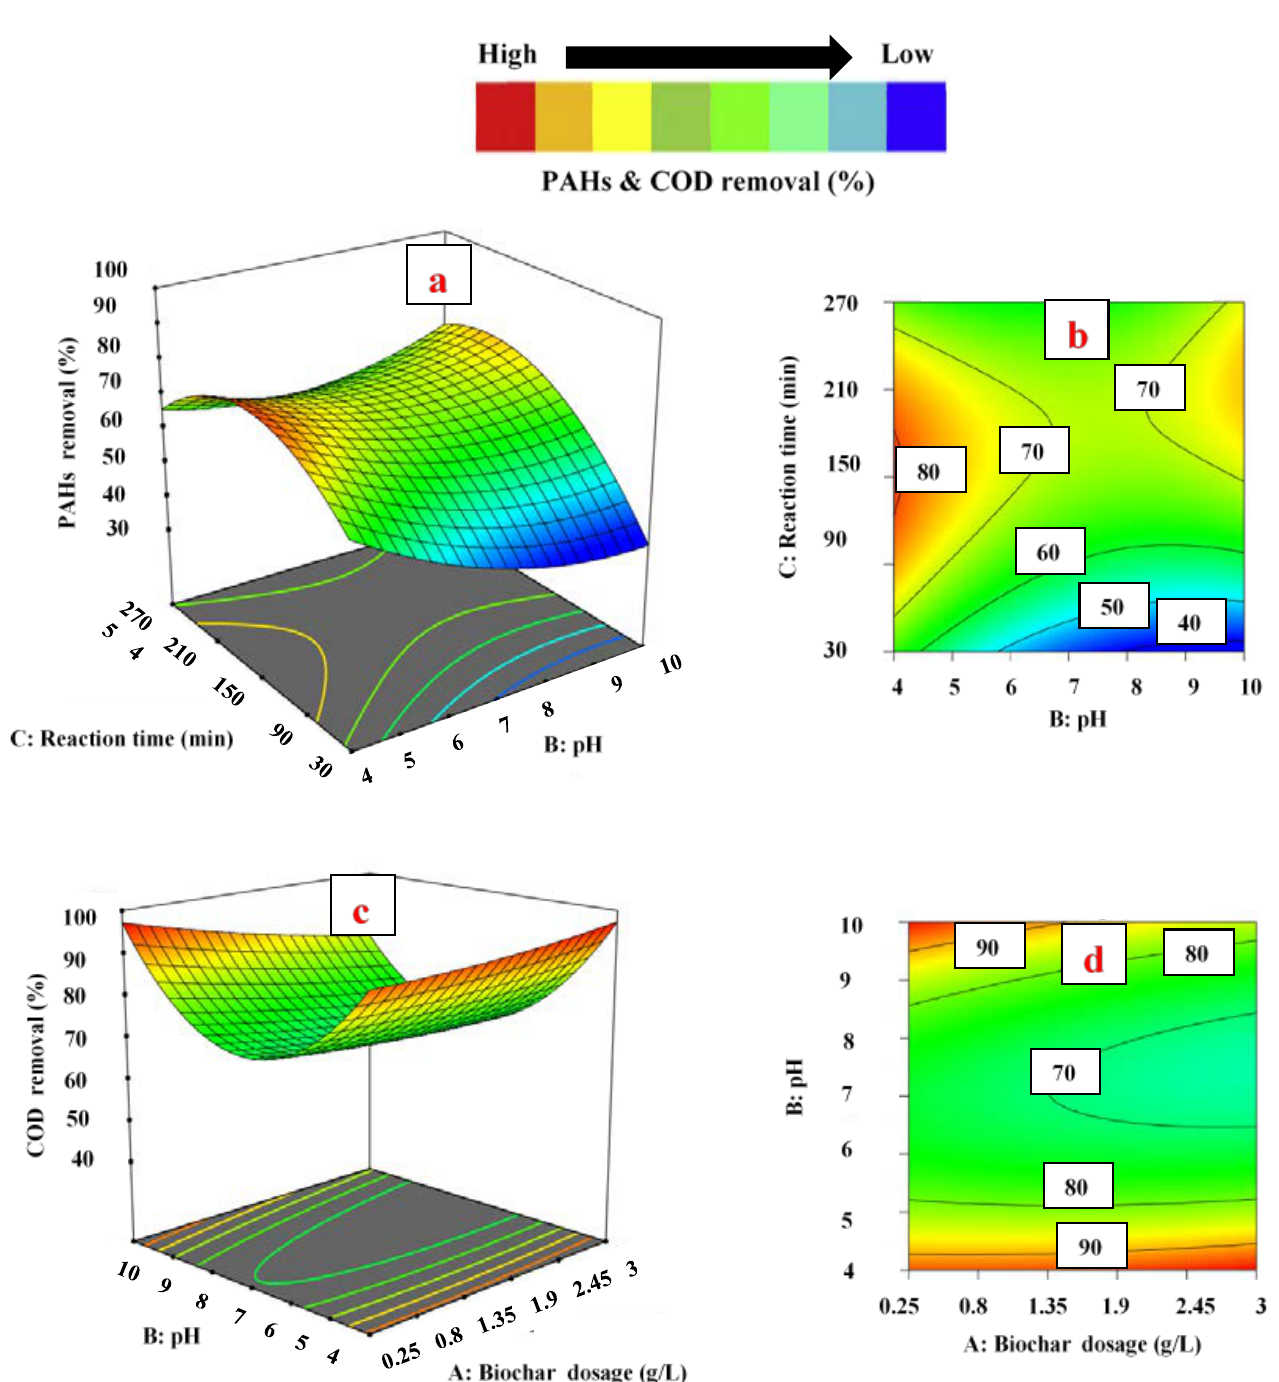
Figure 4. Three-dimensional surface plots for the effect of pH: ( a ) and ( b ) PAH removal ( c ) and ( d ) COD removal.